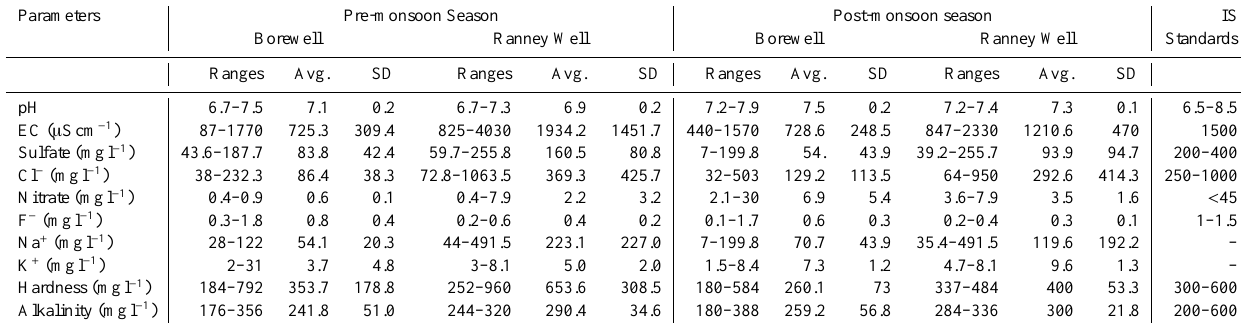
Table 4. Water quality of ground water of the Palla well